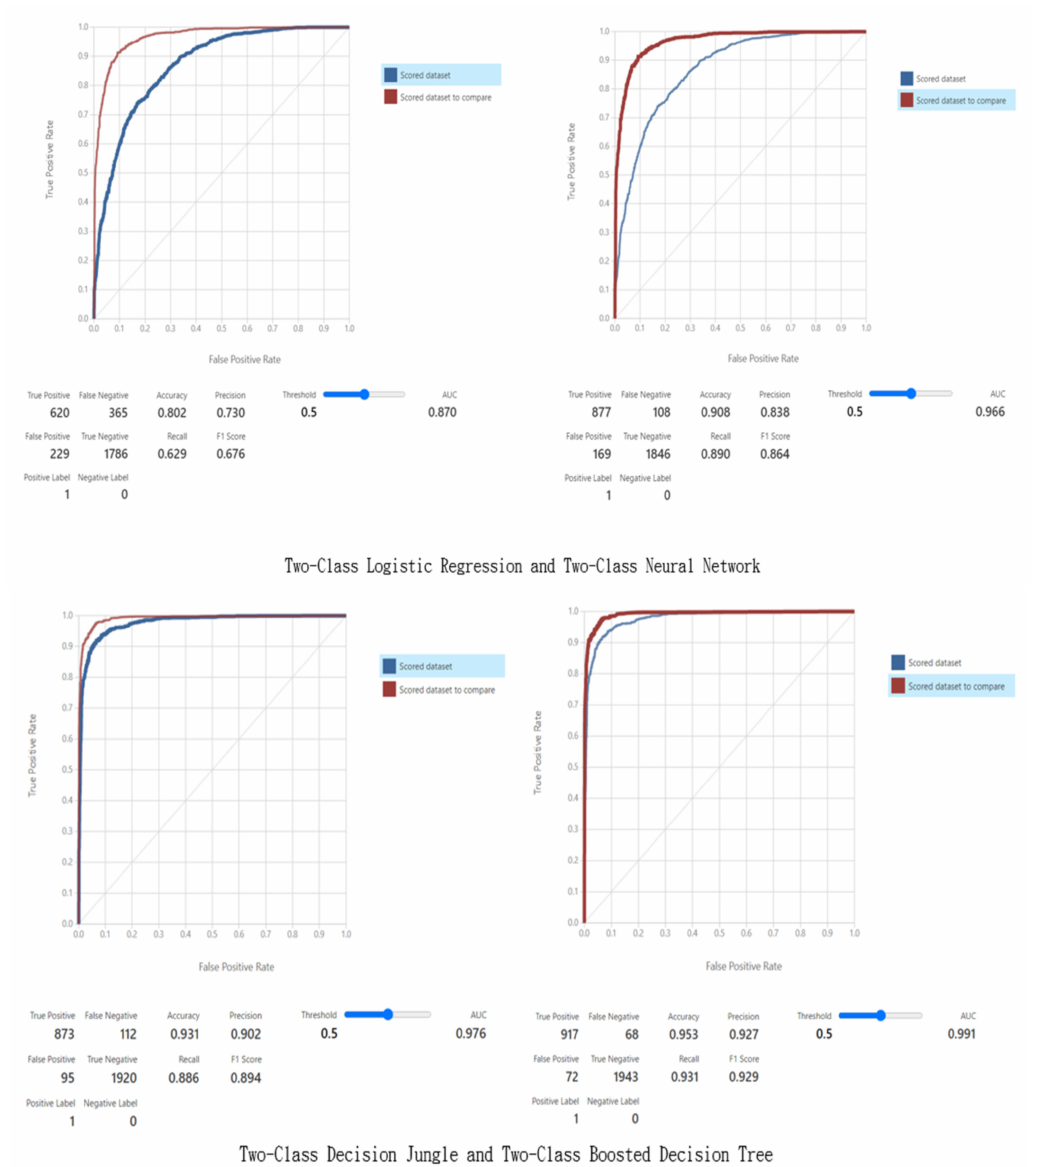
Figure 9. Verification results. Table 1. Verification